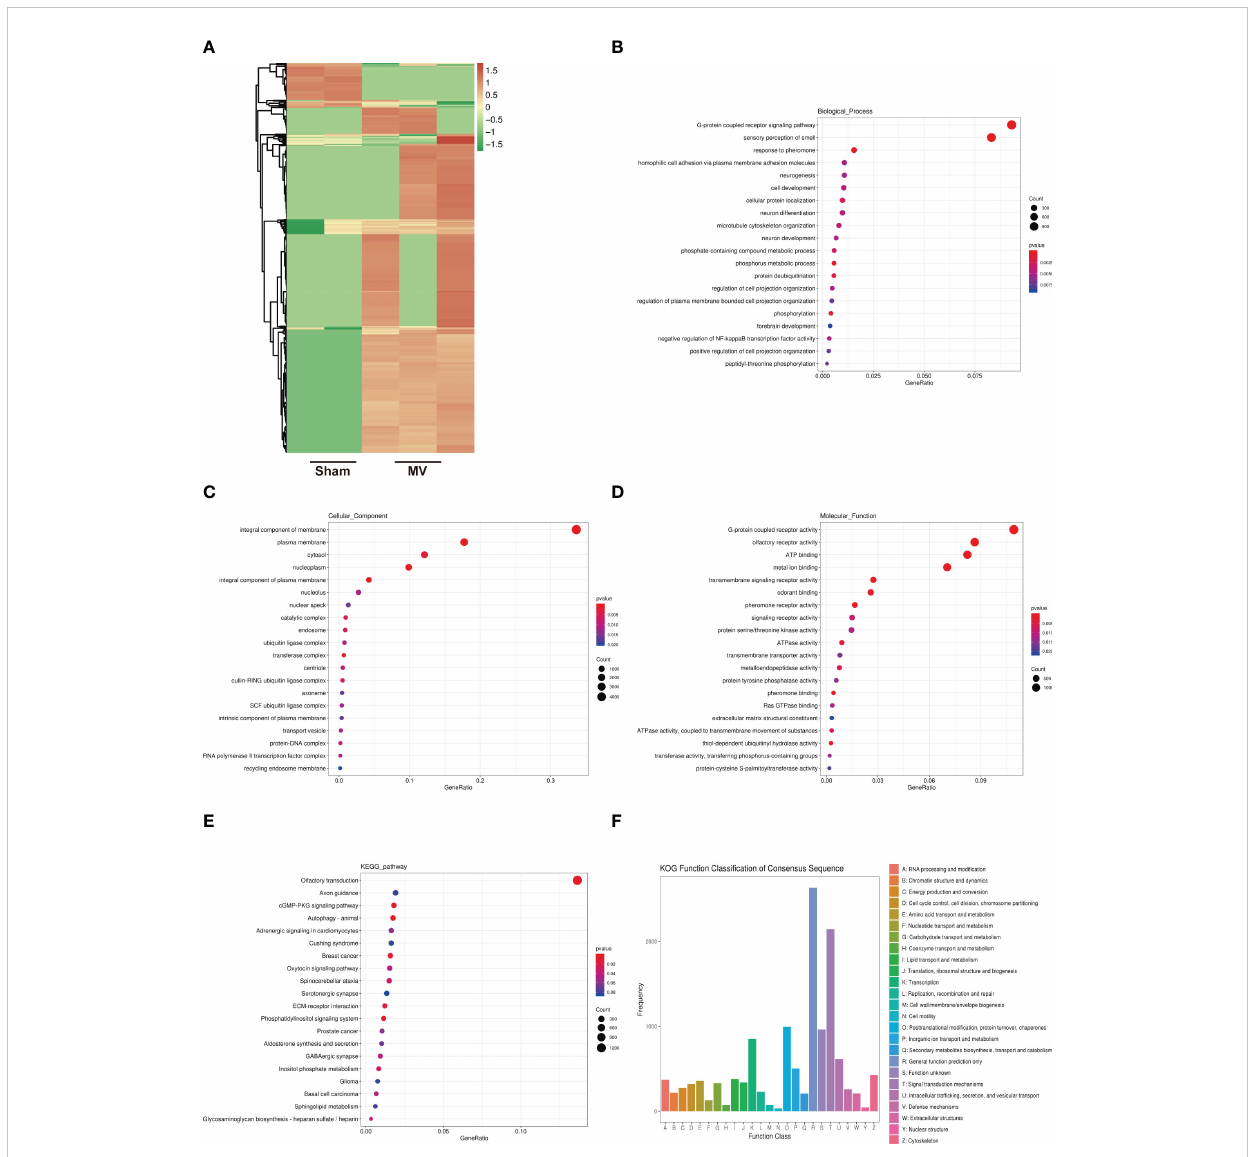
FIGURE 4 Heatmap of lncRNA expression and Enrichment Analysis of differentially expressed lncRNA-targeted mRNA (A) . heatmap differentially abundant lncRNA in the BALF-EVs isolated from Sham and MV mice. (B-D) . Target genes of differentially expressed lncRNA as determined by GO annotation. (E) . KEGG pathway analysis of differentially expressed lncRNA-targeted mRNA. (F) . KOG functional classi fi cation of differentially expressed lncRNA- targeted